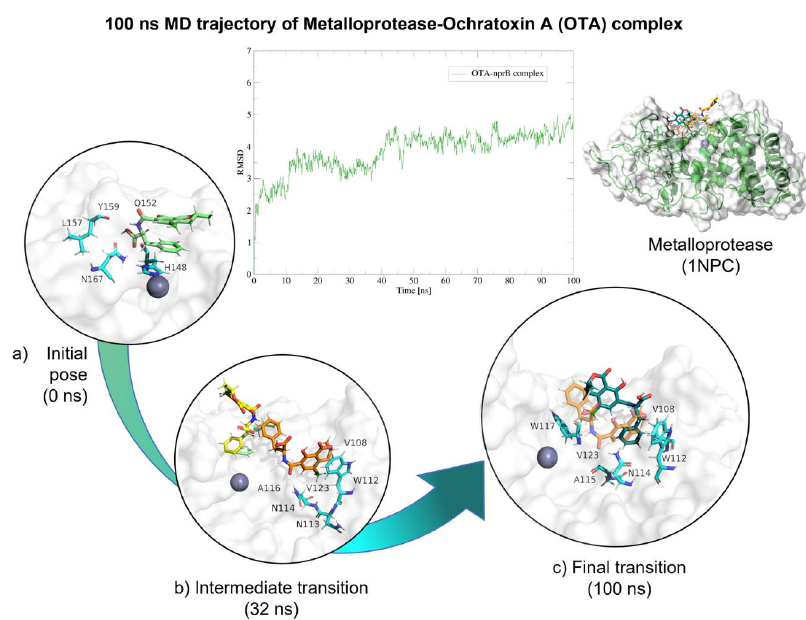
Figure 22. Molecular dynamics of metalloendopeptidase–OTA complex. The root mean squared deviation (RMSD) plot shows changes in the complex conformation with respect to the initial state during 100 (ns). ( a ) Initial pose (0 ns), complex initial state obtained from molecular docking studies. ( b ) Intermediate transition poses visualization where OTA moves from the ligand binding site. ( c ) Final transition showing no dissociation. Green, OTA’s initial pose; Yellow, OTA at 16 (ns); Orange, OTA at 30 (ns); Blue, OTA at 32 (ns), Dark green, OTA at 100 (ns). In vitro experiments showed differences in the neutral metalloendopeptidase capac- ity to reduce OTA at different pH conditions (ANOVA p = < 0.0001; F = 464; Figure 23). Sidak ’s multiple comparisons tests showed differences between the control and all tested pH’s treatments, at pH 4.6 in 8.2% ( p = < 0.0001; t = 7.07; DF = 12); at pH 5 in 14.44% ( p = < 0.0001; t = 12.47; DF = 12); at pH 7 in 45.26% ( p = < 0.0001; t = 39.08; DF 12). The final product was identified unequivocally as α -ochratoxin (Figure 24).